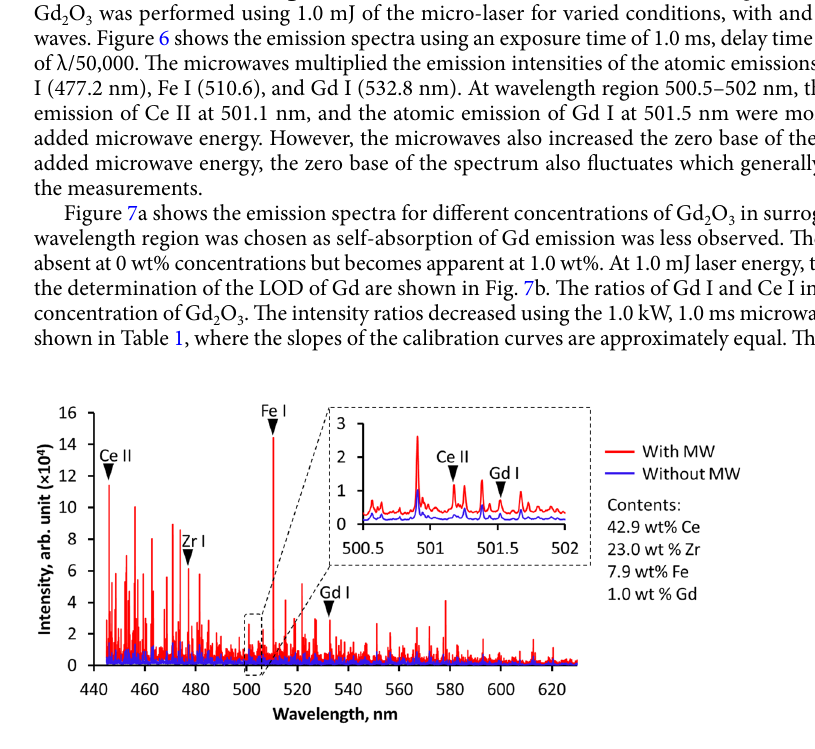
Figure 6. Emission spectra of surrogate nuclear debris (powder mixtures of Gd 2 O 3 , CeO 2 , Zr 2 O 3 , and Fe 2 O 3 ) with 1.0 wt% Gd